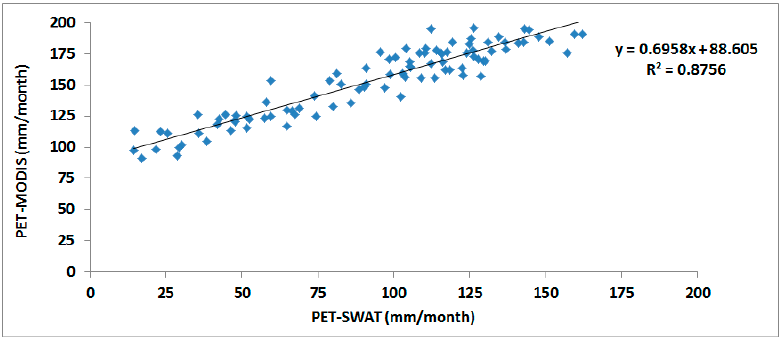
Figure 6. Correlation between potential evapotranspiration (PET) of (MODIS products and SWAT.